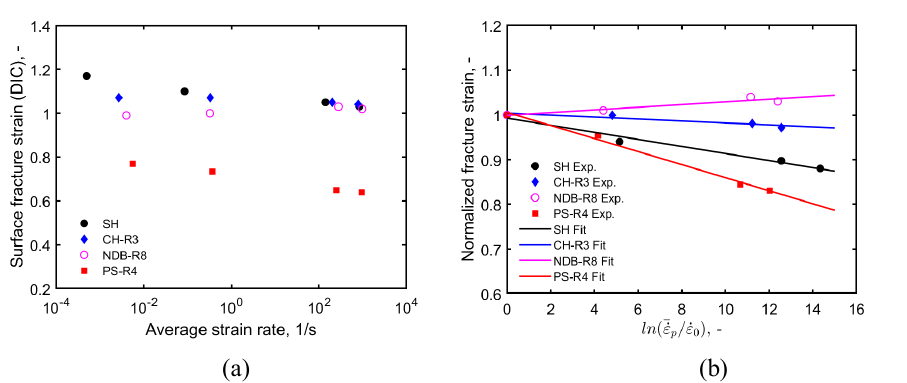
Fig. 9. (a) Surface fracture strain measured by DIC; (b) Strain rate effect on fracture strain for different specimen